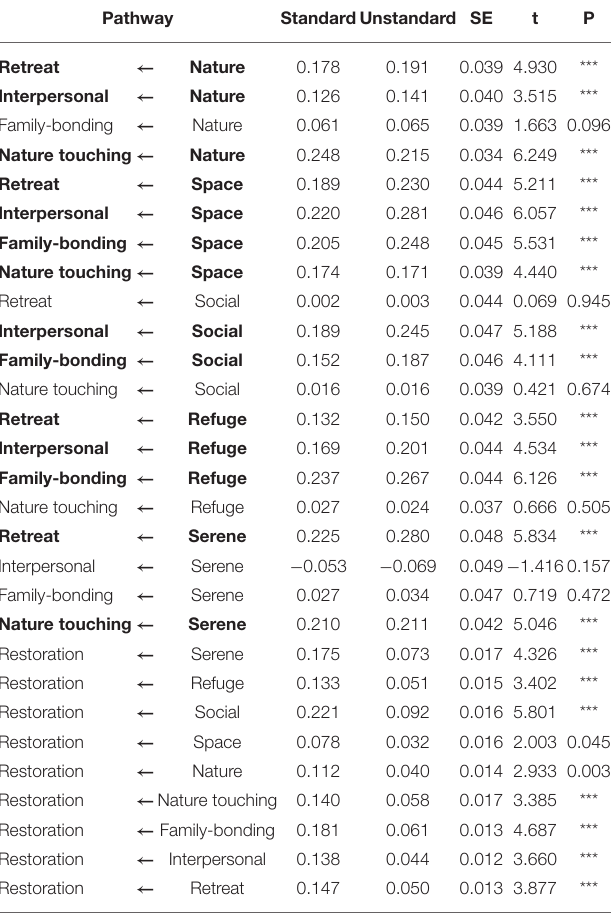
TABLE 8 | Preliminary results of structural equation modeling analysis. Pathway StandardUnstandard